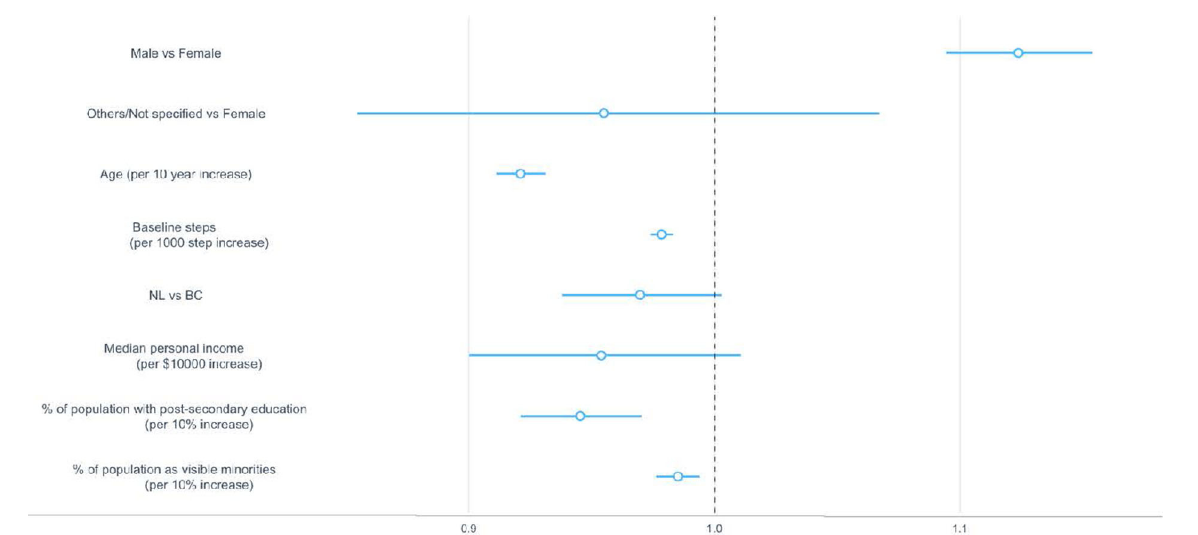
FIGURE6 Hazard ratios and 95% confidence intervals for sociodemographic correlates associated with the likelihood of having the first break. The dotted vertical line indicates a hazard ratio of 1, which means the presence of a correlate neither increased nor decreased the likelihood of having the first break. BC, British Columbia; NL, Newfoundland and Labrador.